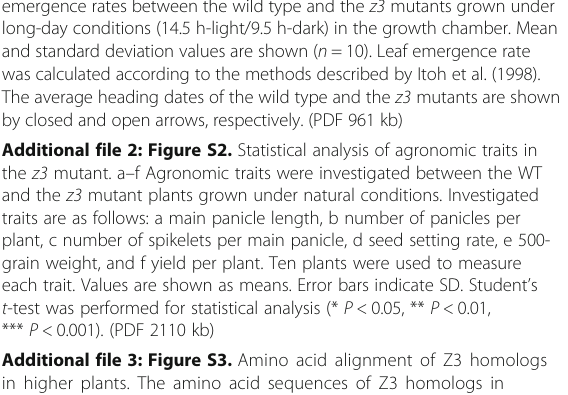
Additional file 4: Figure S4. Confirmation of the overexpression of Z3 by the CaMV 35S promoter in six independent complementation lines. a Genomic PCR analysis for confirmation of rice transformation. The genomic region between the vector and the Z3 transgene was amplified in the transformed lines. All six independent lines were confirmed to be transformed. Primer information is listed in Additional file 8: Table S1. EV, empty vector; Control, vector used for transformation without the Z3 gene. b The overexpression of Z3 by the CaMV 35S promoter in six independent complementation lines. Primers were designed to amplify the transgene mRNA, and are listed in Additional file 8: Table S1. The GAPDH mRNA level was measured as a loading control. (PDF 647 kb) Additional file 5: Figure S5. Phenotypes of the homozygous T-DNA null mutants of Z3 . a Schematic diagrams of the T-DNA insertion. The z3 – 2 and z3 – 3 mutants have a T-DNA insertion in the first exon, but in different locations. These T-DNA knockout mutants of Z3 were derived from the japonica rice cv ‘ Hwayoung ’ . Filled boxes and thick lines indicate exons and introns, respectively. Primers LP1 (left primer 1), RP1 (right primer 1), LP2 (left primer 2), RP2 (right primer 2), and RB (right border primer) used for genotyping are represented as arrows and listed in Additional file 8: Table S1. b Phenotypes of leaf blades from four-month-old WT (Hwayoung), and z3 – 2 and z3 – 3 mutants grown under natural long day (NLD) conditions in the paddy field. c – d Panicle and grain phenotypes of the WT (Hwayoung) and two z3 -knockout mutants at 150 DAS grown in a paddy field. e Days to heading data of the WT, and the z3 – 2 , and z3 – 3 mutants in natural long-day conditions. Means and standard deviations were obtained from 5 plants of each genotype. Error bars indicate SD. Differences between means were compared using Student ’ s t -test (*** P < 0.001). f Genotyping of T-DNA insertion lines. Each LP and RP primer should have amplified about 1.1 kb of genomic DNA if no T-DNA insertion was made. If T-DNA was inserted, the length between the two primers was too large to be amplified. The RB and each RP primer should have amplified an approximately 0.6-kb band if T-DNA was inserted in the first exon. WT (Hwayoung) was used for the control. g Expression of Z3 in the WT and T-DNA knockout mutants by semi-quantitative RT-PCR. Z3 transcripts were not detected in the T-DNA knockout mutants. Ubiquitin 5 ( UBQ5 ) mRNA was measured as a loading control. db, dull-brown colored grain; iv, ivory colored grain. (PDF 1621